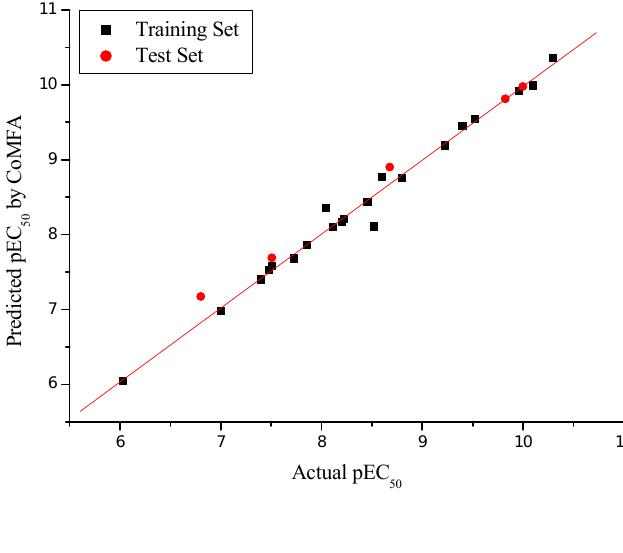
of the training set and the test set using 50